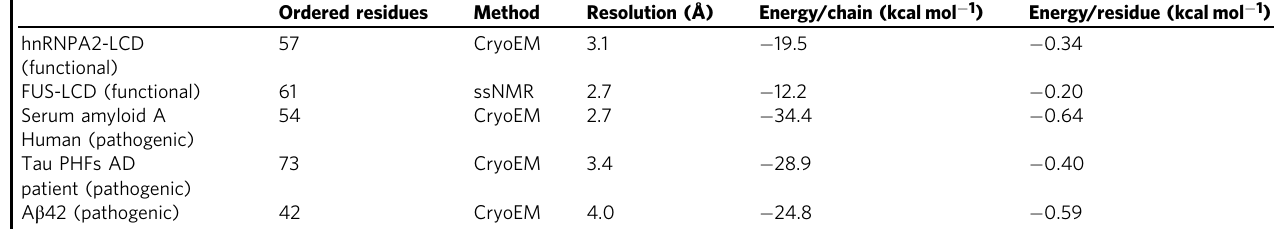
Table 2 Comparative values of solvation standard free energies of functional and pathogenic fi brils.